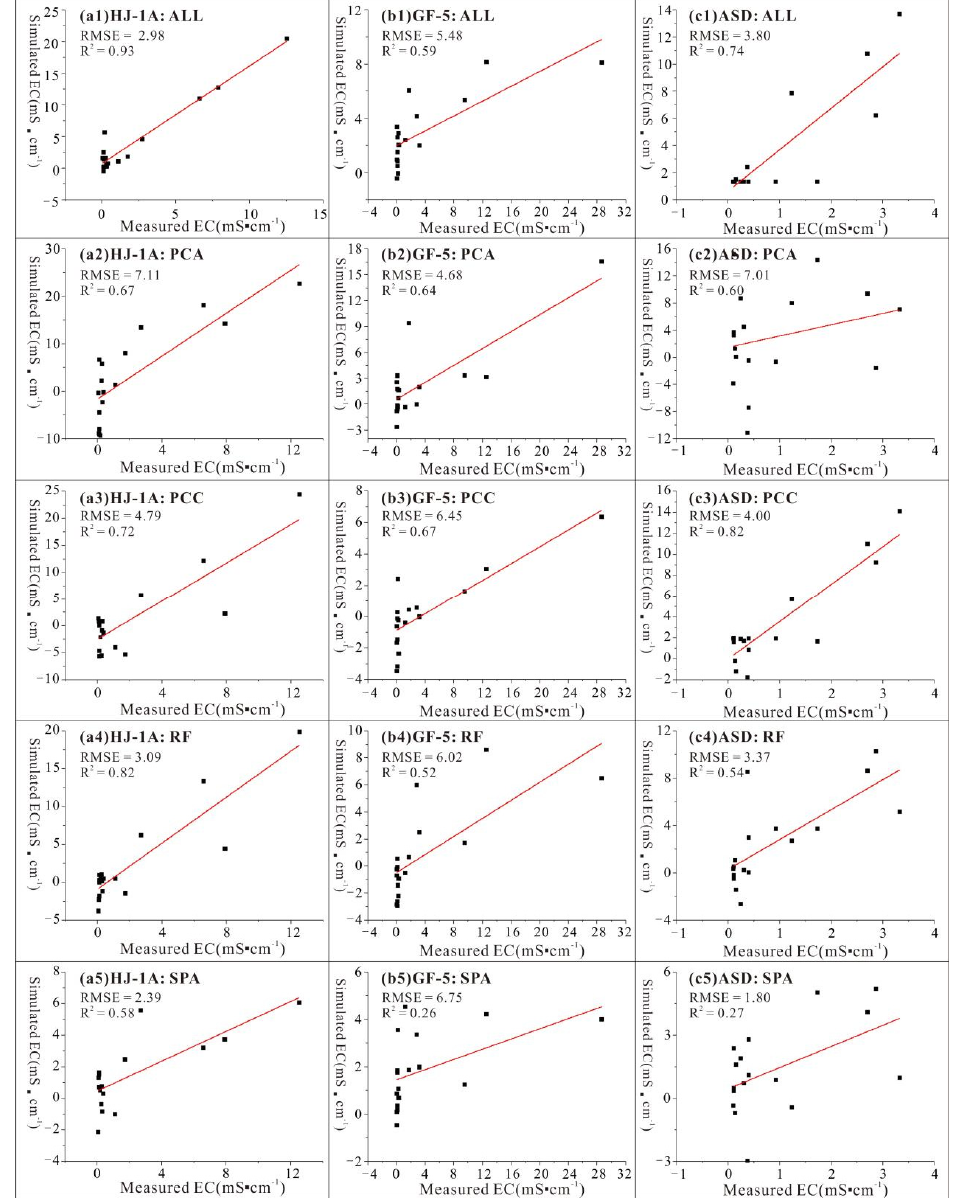
Figure 9. The PSO-BPNN model’s simulation result based on validation dataset of HJ-1A ( a1 – a5 ), GF-5 ( b1 – b5 ), and ASD ( c1 – c5 ) spectra. ‘ALL’ in this figure represents all bands.